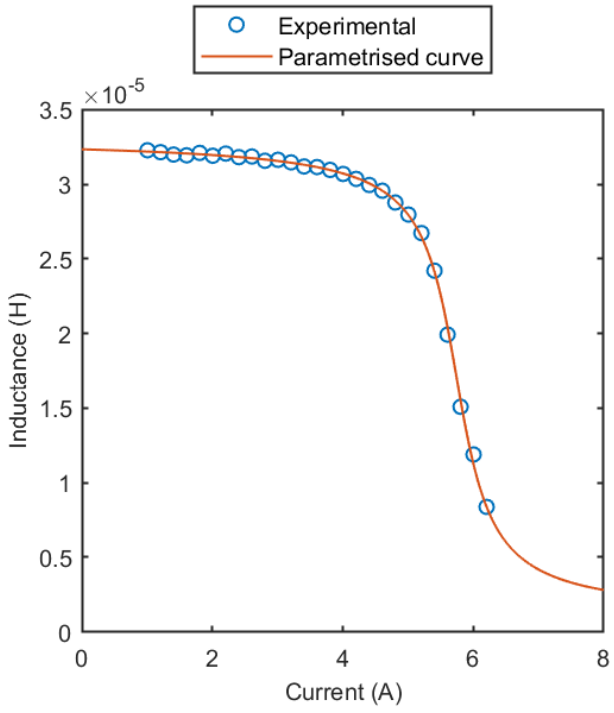
Figure 5. Fitting of the parametrized characteristic on the experimental differential inductance curve for the Coilcraft SER1390-333 inductor.